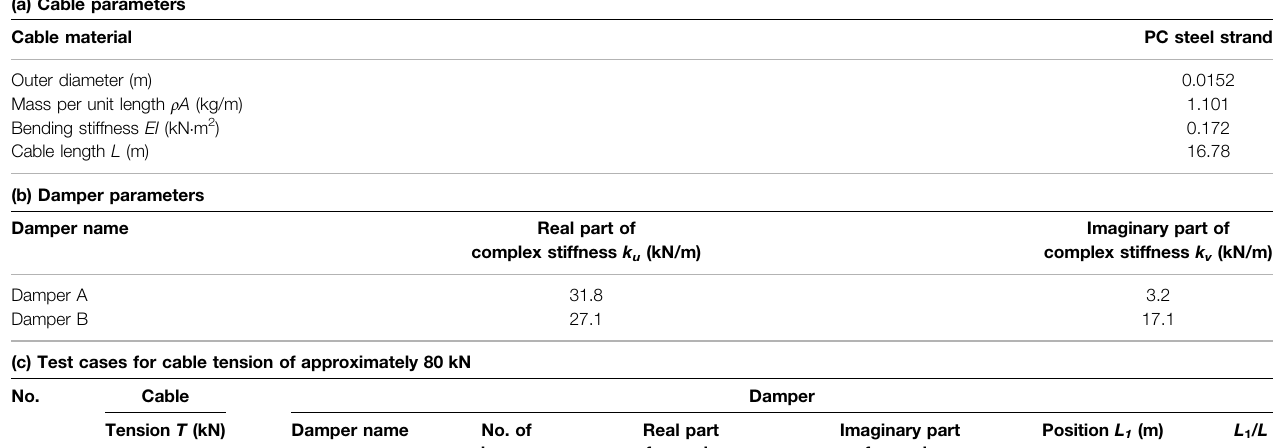
TABLE 2 | Parameters of test specimen and test cases in experimental veri fi cation. (a) Cable